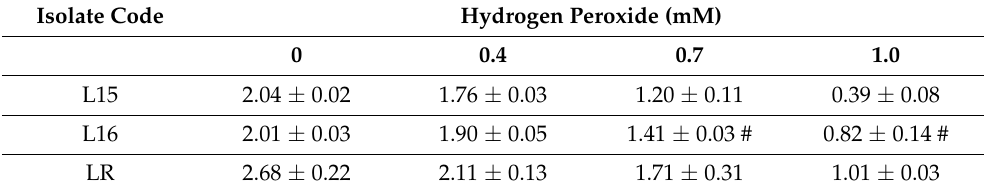
Table 4. Cont. Isolate